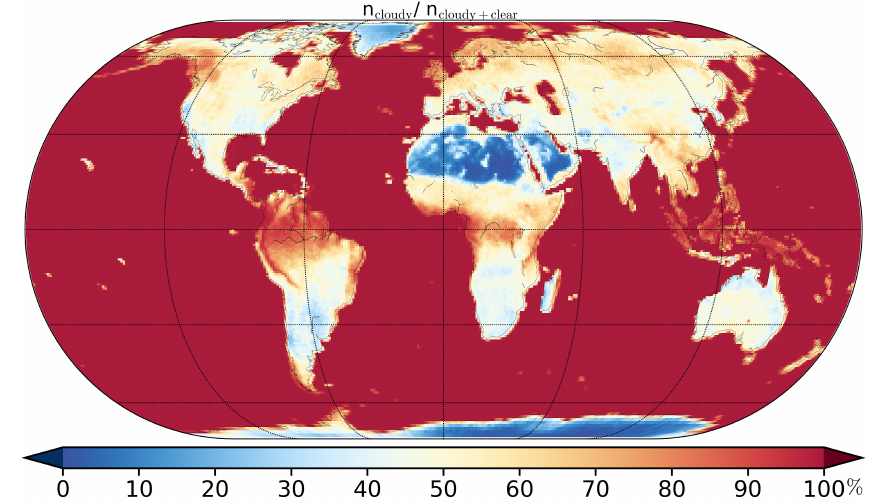
Figure 4. Percentage of cloudy-sky retrievals of all retrievals from January 2003 to the end of the SCIAMACHY mission in April 2012. Here, cloudy-sky retrievals comprise all data products of categories 2 and 3, defined in Sect. 2.3. Table 1. MOZAIC/IAGOS airports used for validation. The temporal coverage with the SCIAMACHY mission is given in years. Number Name Latitude Longitude Alt MOZAIC/IAGOS 1